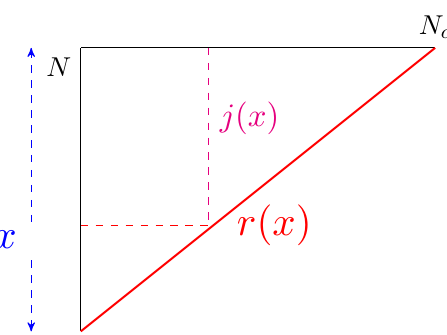
Figure 4 . Triangular Young tableau describing the ensemble (4.40). It is characterised by the limit curve r ( x ) describing the excitation above the Fermi sea of the fermion x . The length of the column j ( x ) describes the R-charge carried by the giant graviton in that